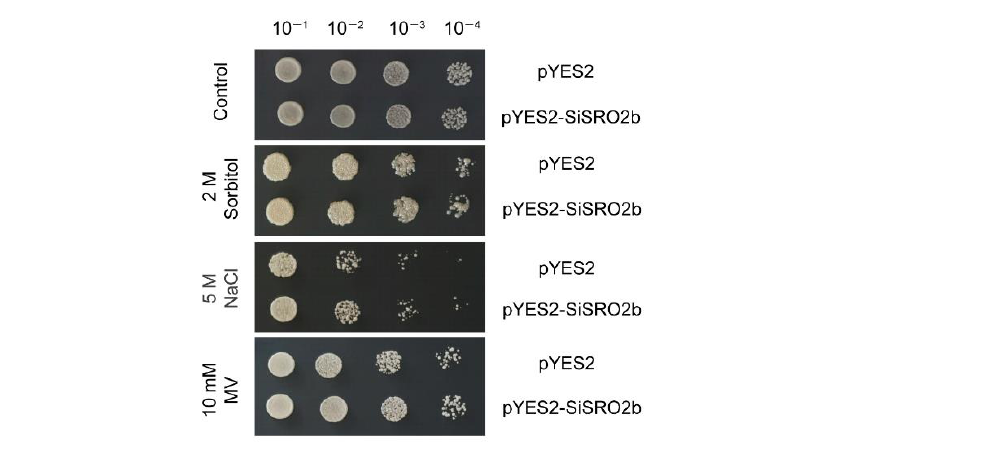
Figure 10. Effect of SiSRO2b expression in yeast under different stress treatments. Yeast cells harboring pYES2-SiSRO2b or the empty pYES2 were treated with 2 M sorbitol, 5 M NaCl or 10 mM MV for 24 h. The cells were then serially diluted and spotted on SD-Ura solid media for 2 days.